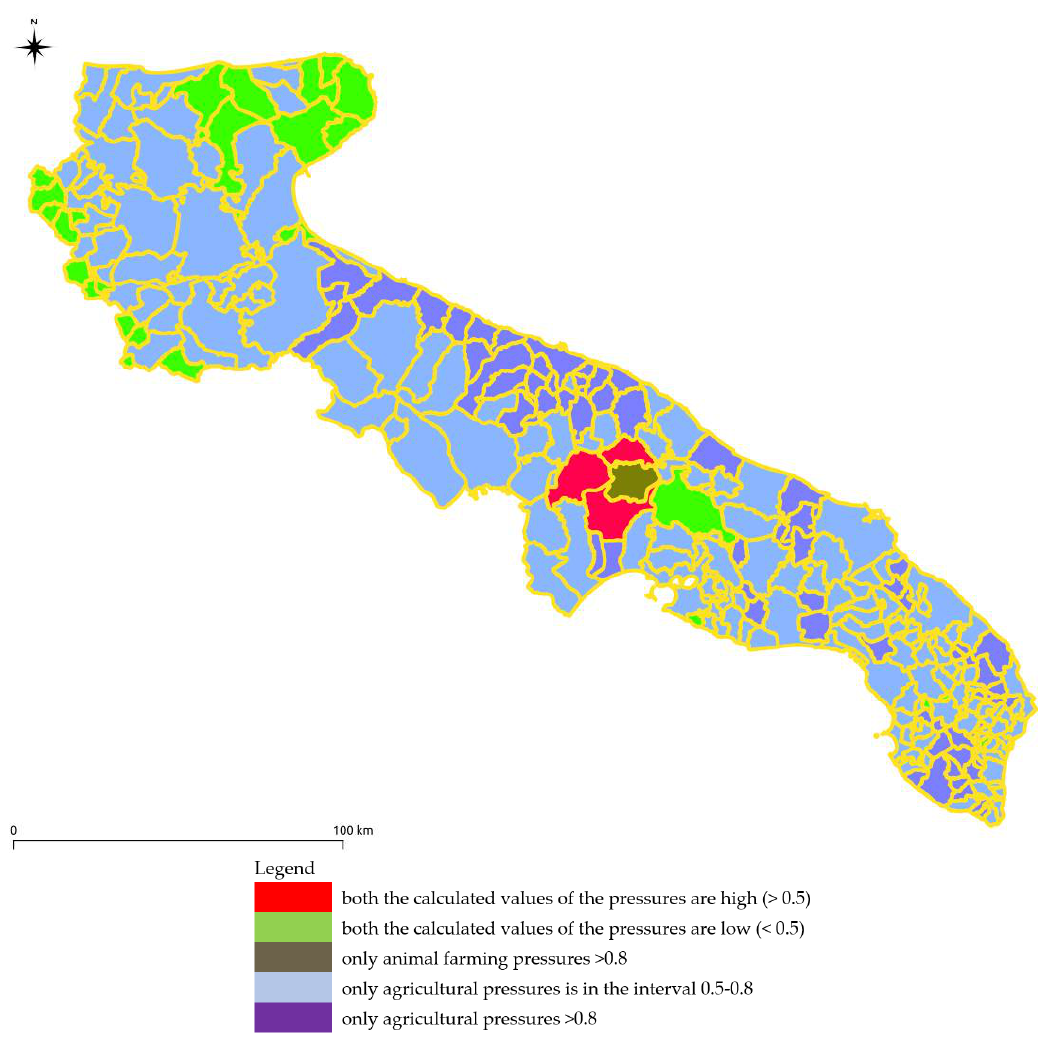
Figure 13. Results deriving from the calculation of the pressures on water bodies posed by agriculture and animal farming.